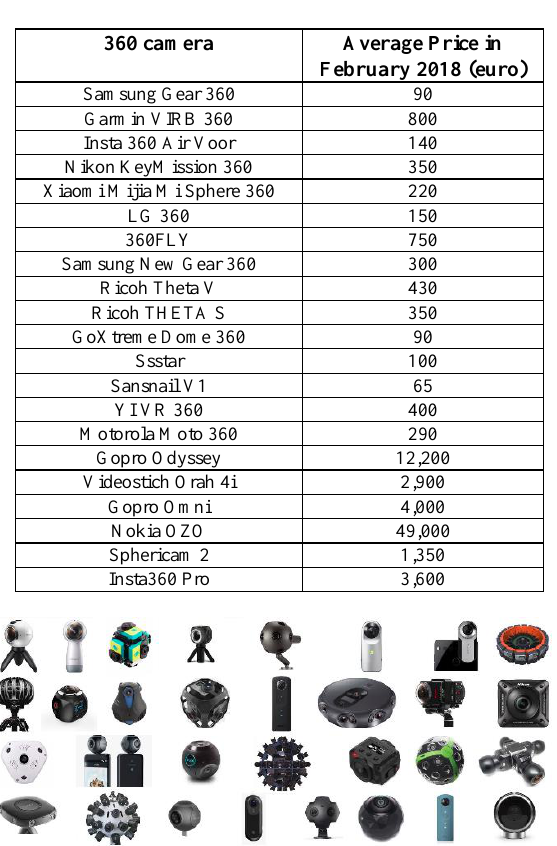
Table 1. Some 360° camera and their average price (February